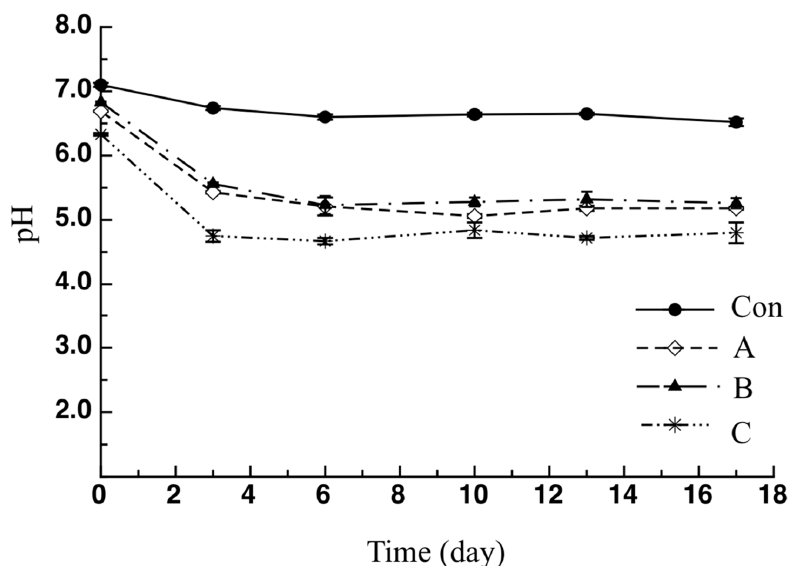
Figure 4. Trend of pH of breaded cod sticks. Data are presented as mean ± SD ( n = 2). Symbols: experimental data; Con: sticks breaded with sole no active mix; A: sticks breaded with sole active mix; B: sticks breaded with pomegranate peel powder/no active mix; C: sticks breaded with pomegranate peel powder/active mix.